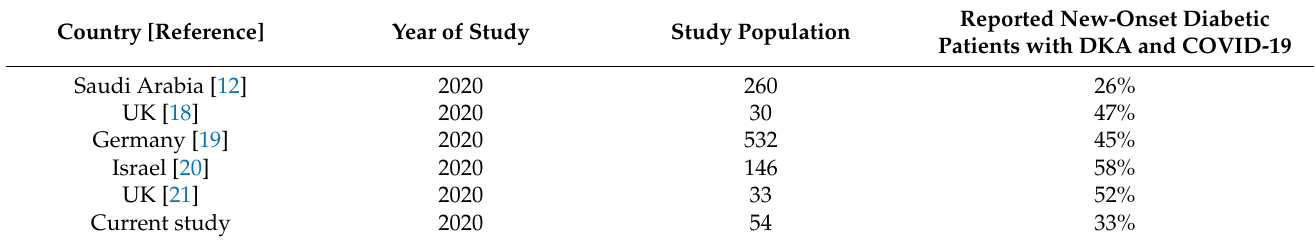
Table 3. Studies reported DKA among patients with